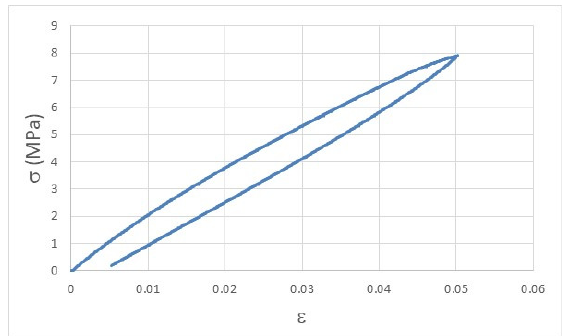
Figure 3. Stress-strain curve of a P h printed specimen after 1 cycle of load-unload experiment, highlighting the permanent deformation due to the elastic behavior of polymeric materials.